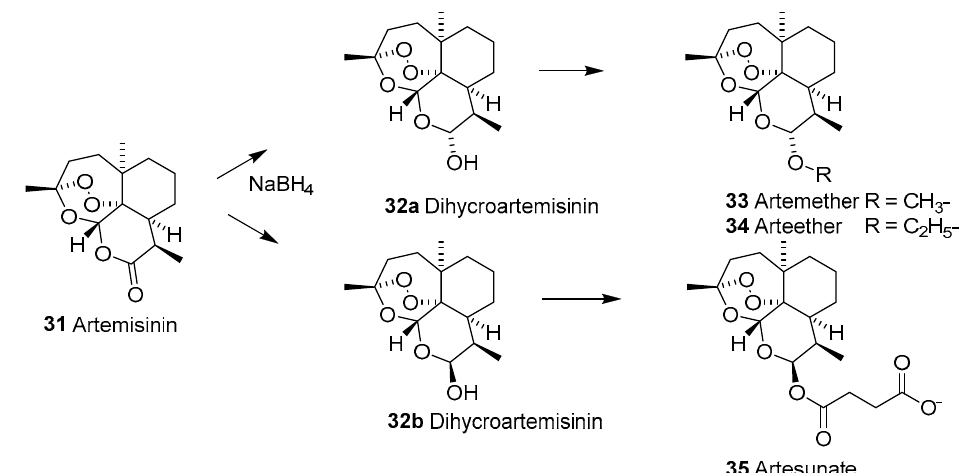
Scheme 3. Conversion of artemisinin to clinical used artemisinins: artemether ( 33 ), arteether ( 34